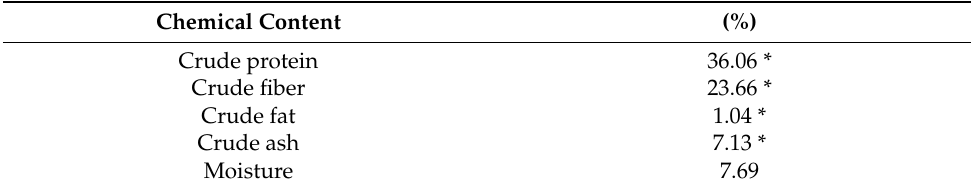
Table 1. Chemical composition of starting